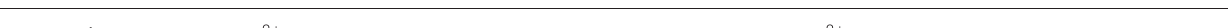
FIGURE 10 | the VEGF-induced Ca 2 + increase ( n = 4) AMTB (20 µ M) failed to suppress the VEGF-induced Ca 2 + increase ( n = 4). (D) Summary of the experiments with VEGF, CPZ and AMTB. The asterisks (*) designate significance differences with and without the respective TRPV1 and TRPM8 channel antagonists (CPZ/AMTB) ( n = 4–12; p < 0.05 at the minimum; paired tested). The hashtags (#) indicate statistically significant differences of fluorescence ratios with and without CPZ ( n = 4–12; p < 0.01 at the minimum; unpaired tested). (E) VEGF (10ng/ml) induced a reversible Ca 2 + increase (20min) ( n = 12). (F) Summary of the long-term recording with VEGF. The asterisks (*) designate significance differences with and without VEGF ( n = 12; p < 0.001). (G) VEGF (10ng/ml) induced a Ca 2 + increase ( n = 8) whereas non-treated control cells showed a constant Ca 2 + baseline ( n = 10). (H) Same experiments as shown in (G) , but in the presence of CPZ. CPZ (10 µ M) clearly suppressed the VEGF-induced Ca 2 + increase ( n = 10). (I) Summary of the experiments with VEGF and CPZ. The asterisks (*) designate significance in [Ca 2 + ] i with VEGF ( n = 8; p < 0.01; paired tested). The hashtag (#) denotes a statistically significant difference of fluorescence ratios with and without CPZ ( n = 8–10; p < 0.001; unpaired